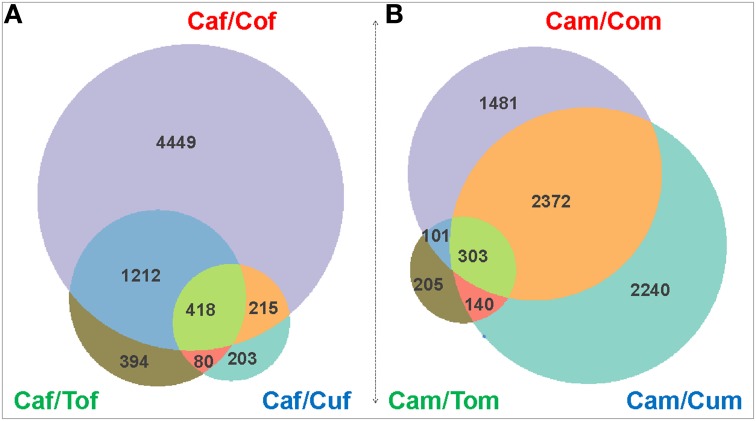
Up-regulated genes between the original and the derived hosts. Venn diagrams showed up-regulated genes in adult females (A) and males (B). Ca, Co, Cu, and To denote the original host plant, cabbage, and derived host plants cotton, cucumber, and tomato, respectively.